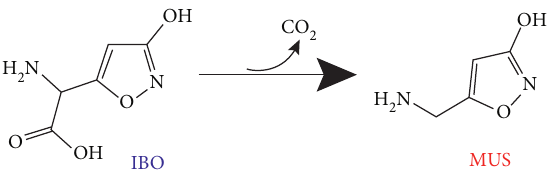
Figure 2: IBO transformation into MUS through drying-mediated decarboxylation